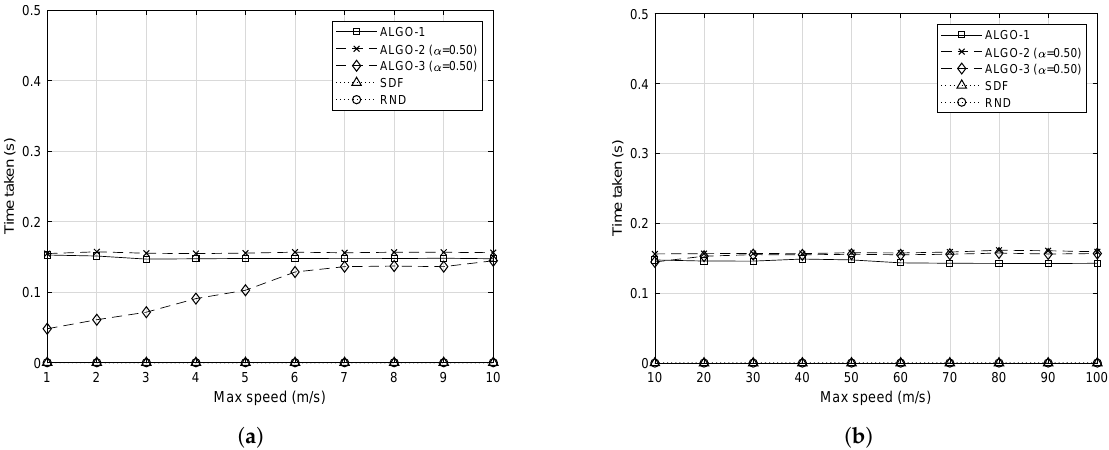
Figure 9. Average time taken to solve the given optimization problem with respect to different upper bounds on the speed of 50 mobile IoT devices. ( a ) IoT devices are moving at a slow speed; ( b ) IoT devices are moving at a fast speed.